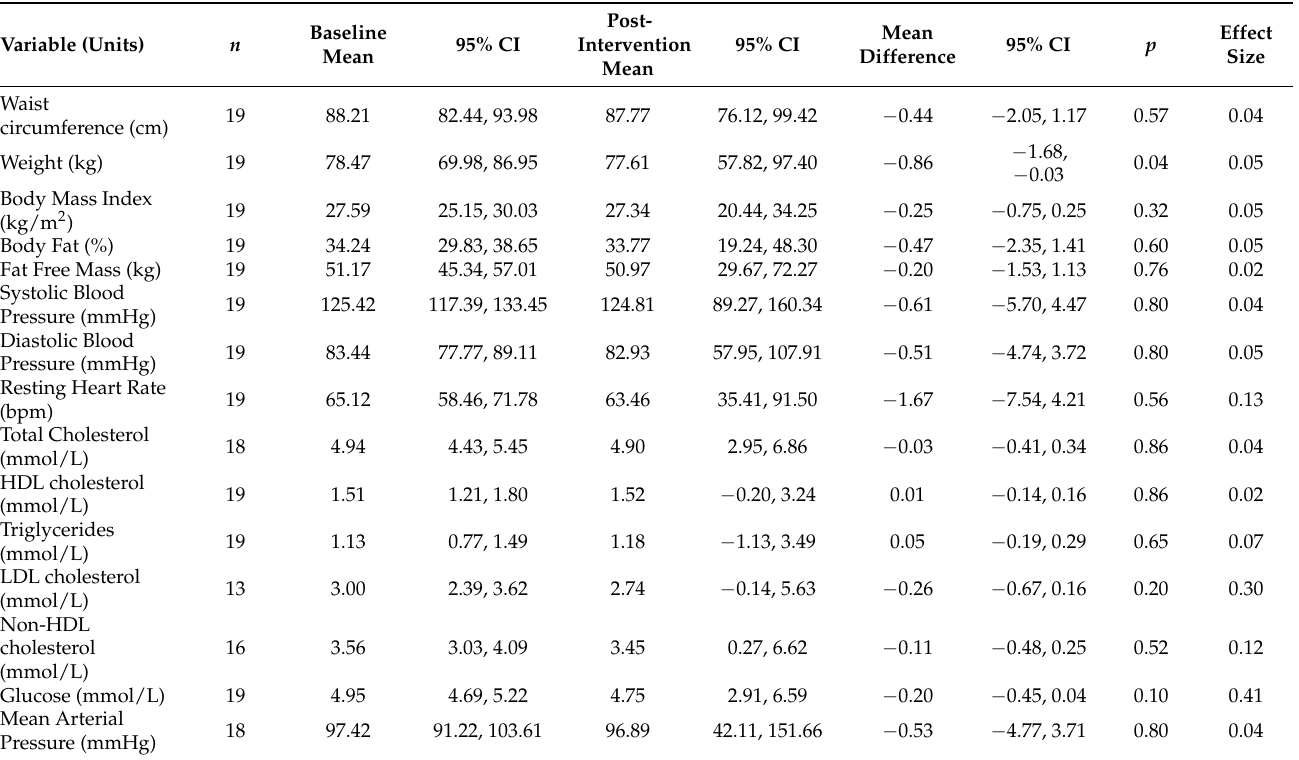
Table 4. Changes in anthropometric and cardiometabolic risk markers from baseline to post- intervention.